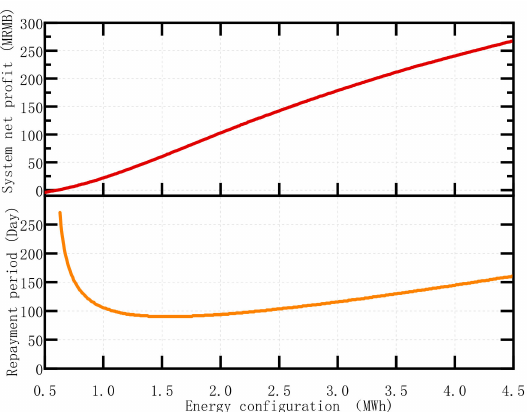
Figure 11. The relationships between system net profit, repayment period, and energy configuration.